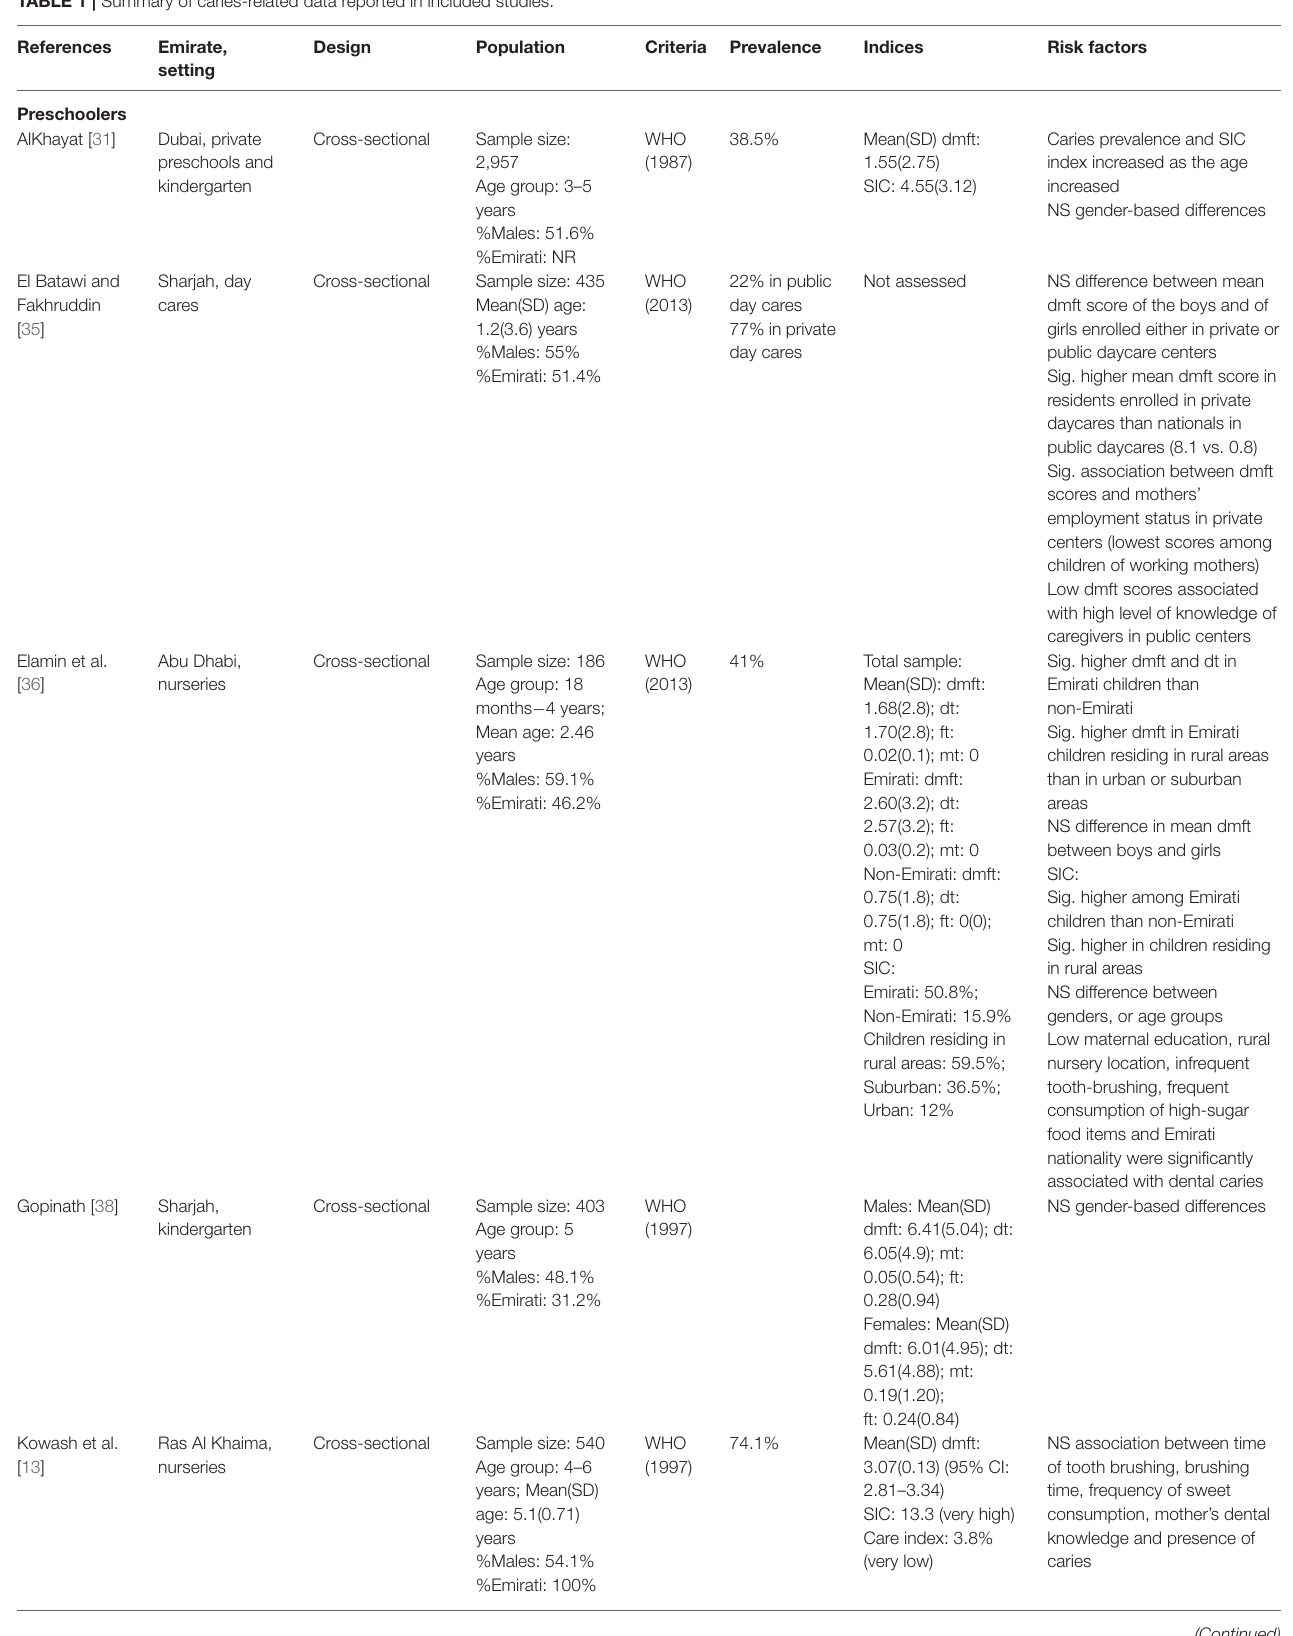
TABLE 1 | Summary of caries-related data reported in included